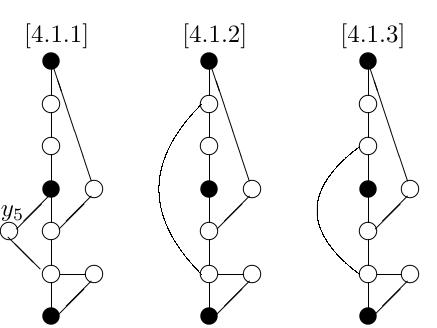
Fig. 15: Fixing v 7 for a maximum backbone tree of type 1 in case [4 . 1] .